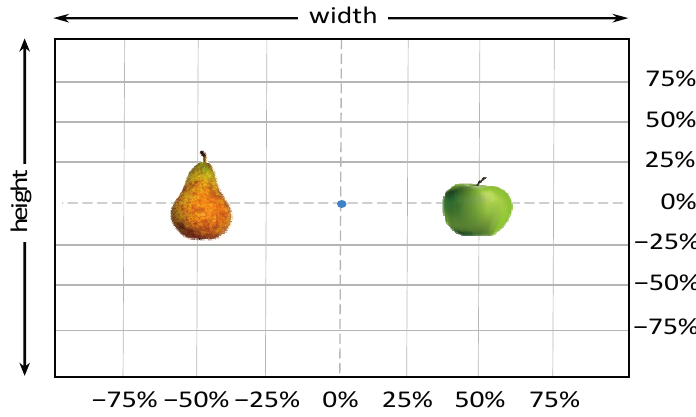
Figure 8. Representation of the right (red point) and left camera (blue point) and their visible area.